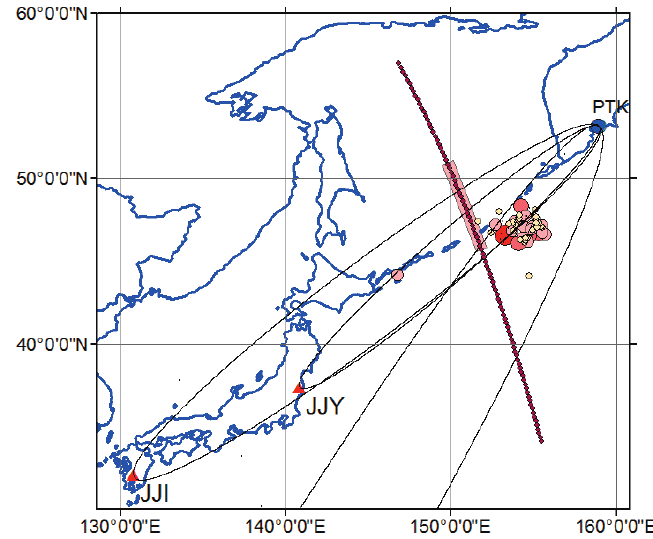
Figure 1. Map showing the positions of the Petropavlovsk-Kamchatsky (PTK) station and the JJI and JJY VLF/LF transmitters, together with the epicenters of the earthquake on November 15, 2006, and its aftershocks (after the US Geological Survey catalog). The ellipses show the sensitivity zones for the JJI, JJY and NWC transmitters. Part of a night-time orbit of the DEMETER satellite that passes above the earthquake area is indicated. Pink rectangle, section where effects are